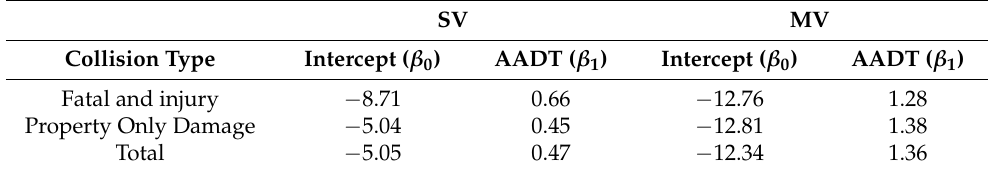
Table 2. SPF Coefficients for Single and Multiple Collisions on Urban Roadway Divided